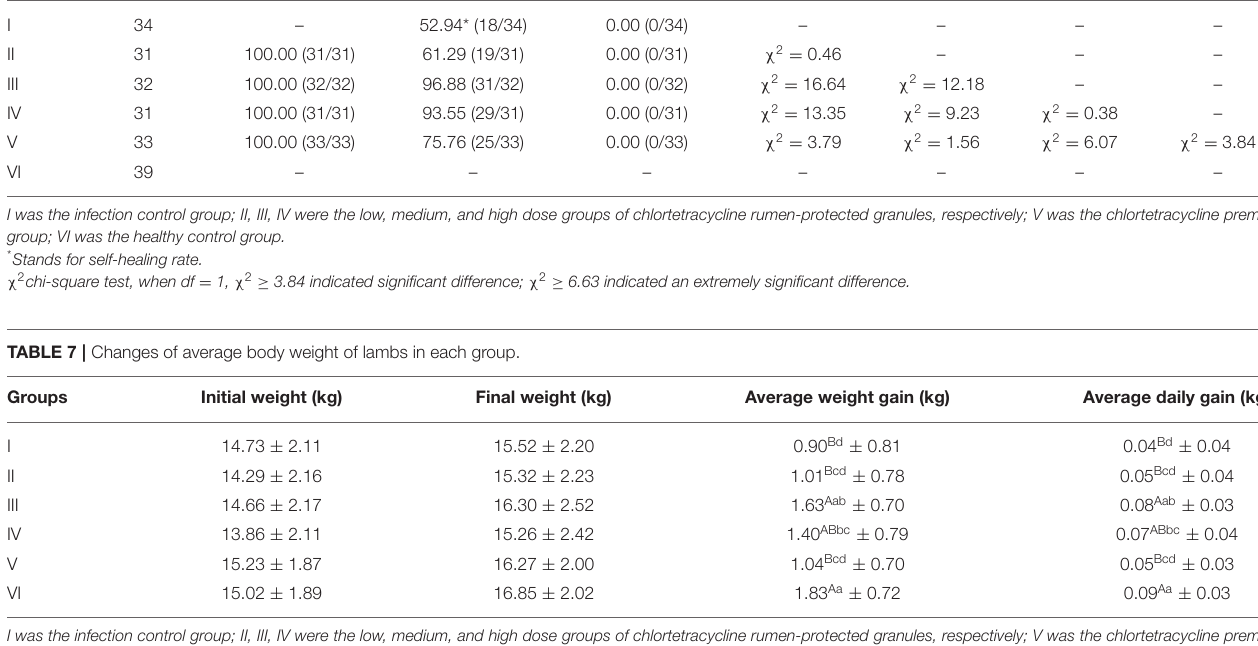
Compared with group II